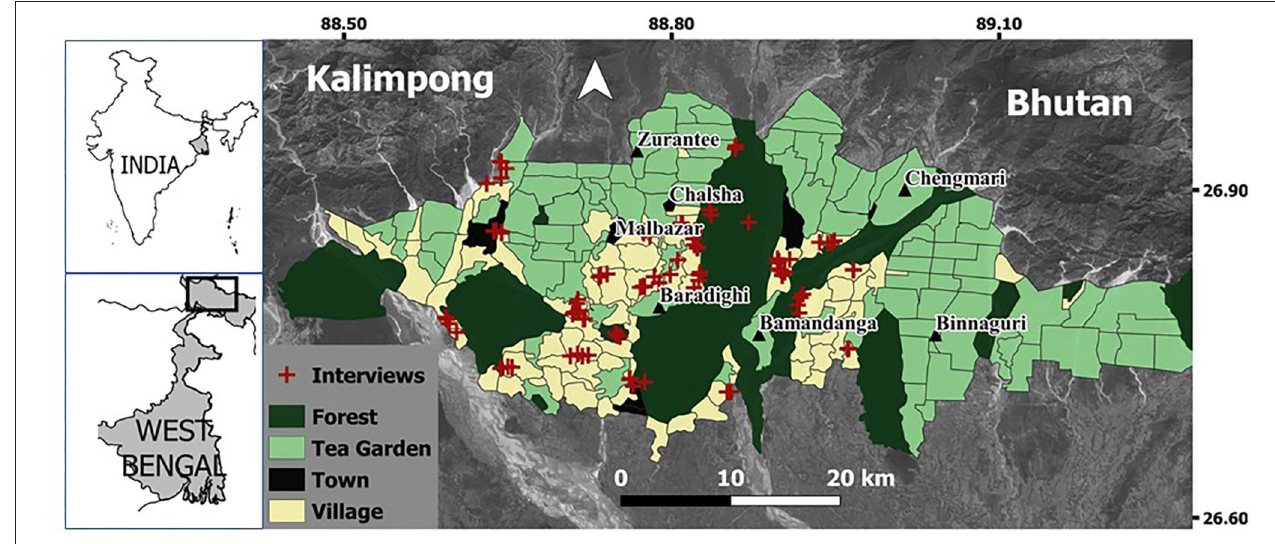
FIGURE 1 | Map of the study area showing locations of sampled household in West Bengal,